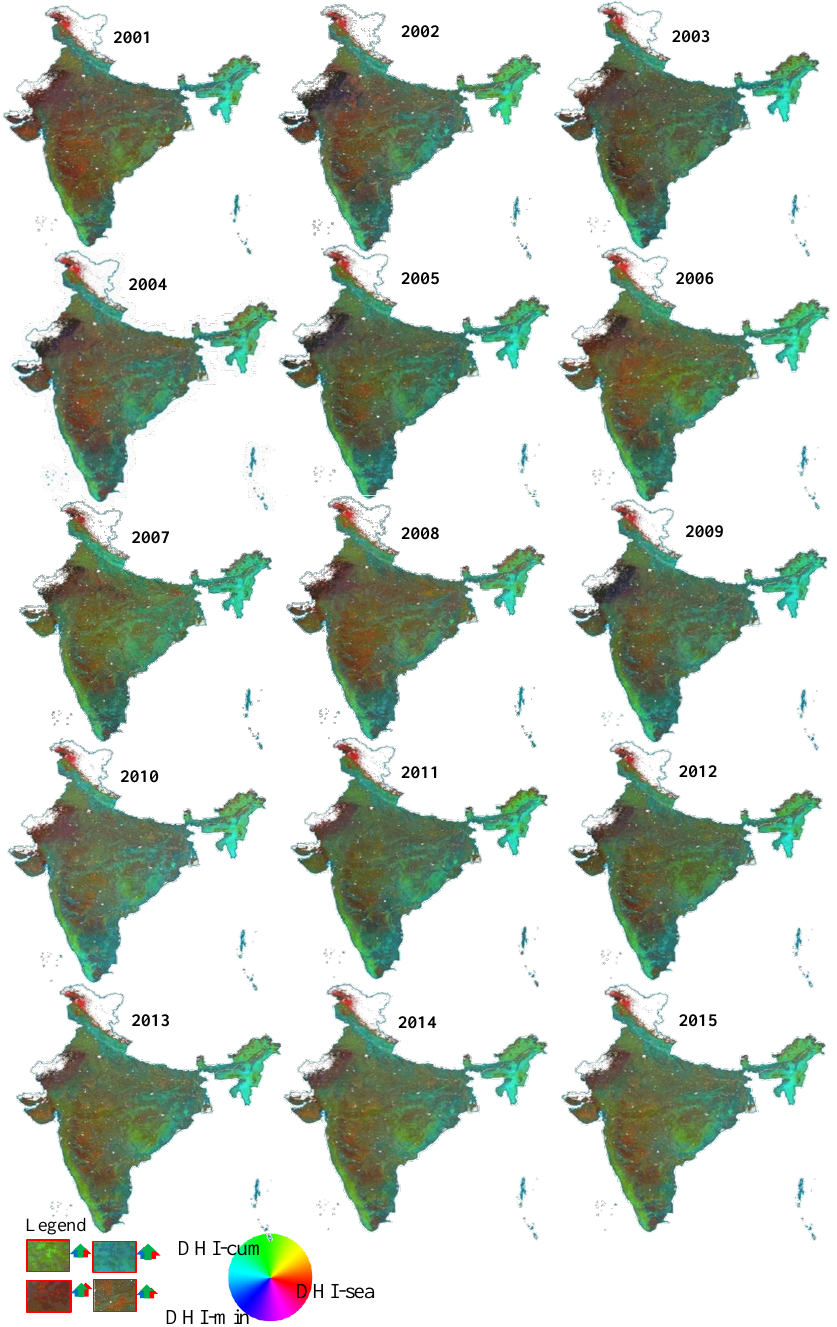
Figure 5. The composite image of three DHI components were mapped from 2001 to 2015, where, DHI-cum was assigned with the green band, DHI-min was assigned with the blue band, and DHI-sea was assigned with the red band.